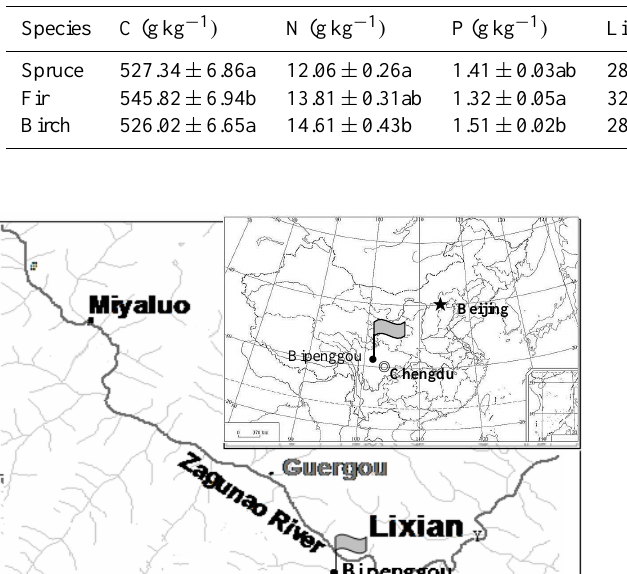
Table 1. Initial litter chemistry of each tree species expressed as potential litter quality variables ( n = 5 means ± SE). Different letters denote significant differences ( p <0.05) among species.